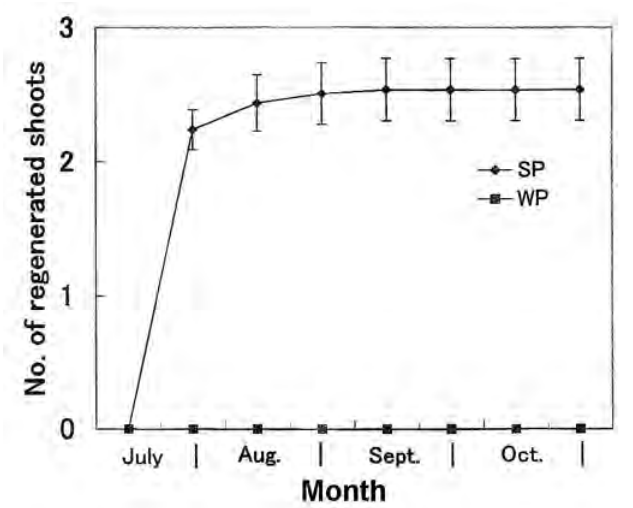
Fig. 8 - Effect of summer pruning on regenerated shoot numbers of peach trees. Data are presented as mean ± standard error ( se ).